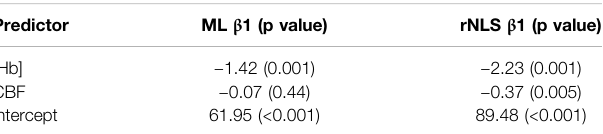
TABLE 3 | Results of a bivariate regression of OEF 0 against CBF 0 and [Hb] for 30 healthy volunteers analyzed with the ML (ensemble of MLPs) and rNLS fi tting